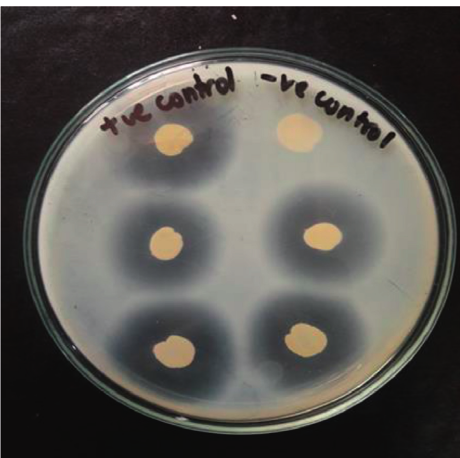
Figure 4: S. aureus on DNase